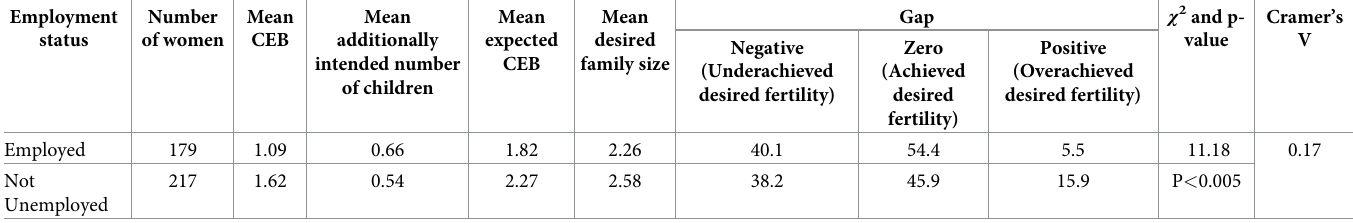
Table 6. Mean number of children ever born (CEB), mean expected CEB, mean desired family size and the gap between mean CEB and mean expected CEB by women’s employment